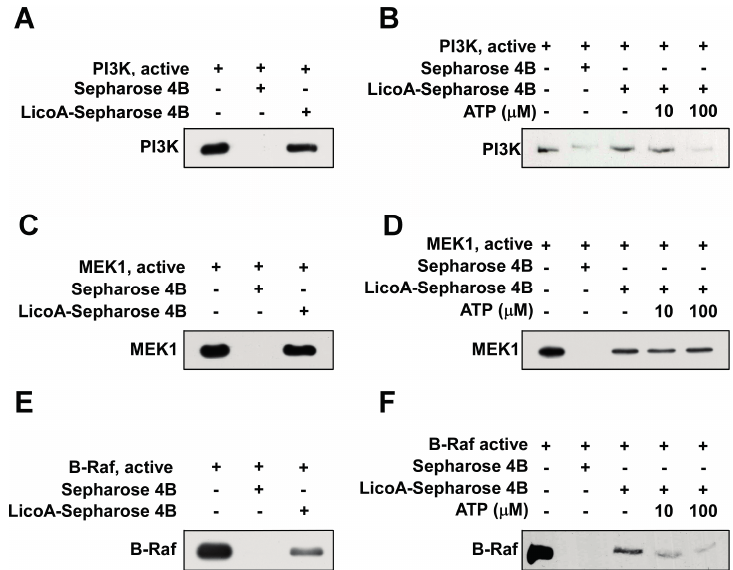
Figure 4. LicoA directly binds with PI3K, MEK1, and B-Raf. ( A , C and E ) LicoA specifically binds with PI3K ( A ), MEK1 ( C ), and B-Raf ( E ) in vitro . The PI3K (or MEK1, B-Raf)—LicoA binding was confirmed by immunoblotting using antibodies against PI3K(p110), MEK1 or B-Raf: Lane 1 (input control), PI3K, MEK1, or B-Raf protein standard; Lane 2 (control), Sepharose 4B was used to immunoprecipitate PI3K, MEK1, or B-Raf, as described in the Experimental Section; Lane 3, LicoA-Sepharose 4B affinity beads were used to immunoprecipitate PI3K, MEK1, or B-Raf. ( B , D and F ) LicoA competes with ATP to bind with PI3K and B-Raf but not MEK1. Active PI3K, MEK1, or B-Raf (200 ng) was incubated with ATP at different concentrations (0, 10, or 100 µM) and 100 µL of LicoA-Sepharose 4B or 100 µL of Sepharose 4B (negative control) in reaction buffer for a final volume of 500 µL. The mixtures were incubated at 4 °C overnight with shaking. After washing, the immunoprecipitated proteins were detected by Western blotting: Lane 1 (input control), PI3K, MEK1, or B-Raf protein standard; Lane 2 (negative control), PI3K, MEK1, or B-Raf bound with Sepharose 4B; Lane 3 (positive control), PI3K, MEK1, or B-Raf binding with LicoA—Sepharose 4B. Each experiment was performed a minimum of three times and representative blots are